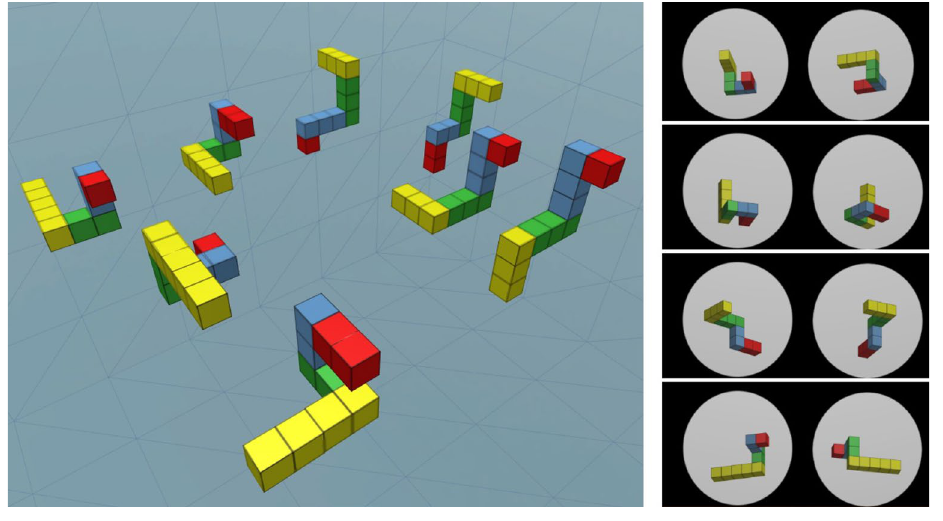
Figure 7. Mental-rotation block-shape